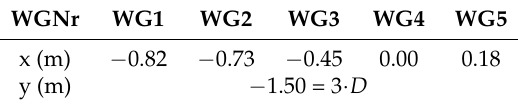
Table 1. Location of the wave gauges (WG) in relation to the global coordinate system. The origin is in the centre of the tank and the spacing is defined by a Golomb ruler—outside diameter of the cylinder D equal 0.5 m. WGNr WG1 WG2 WG3 WG4